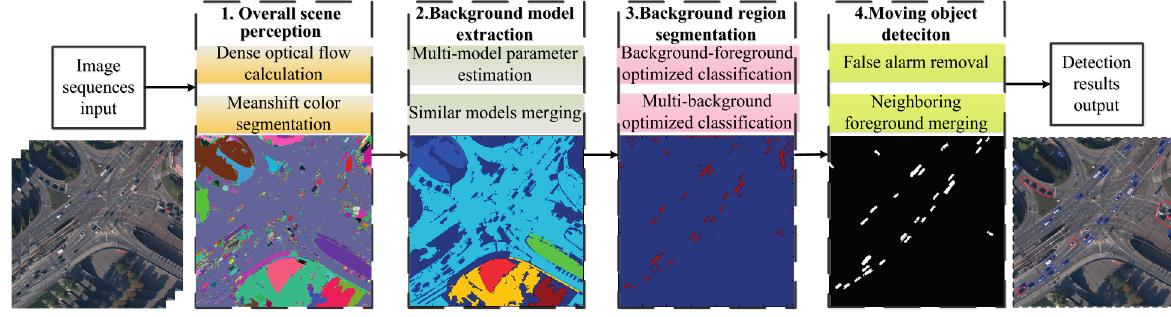
Figure 2. The flowchart of moving object detection based on multi-model